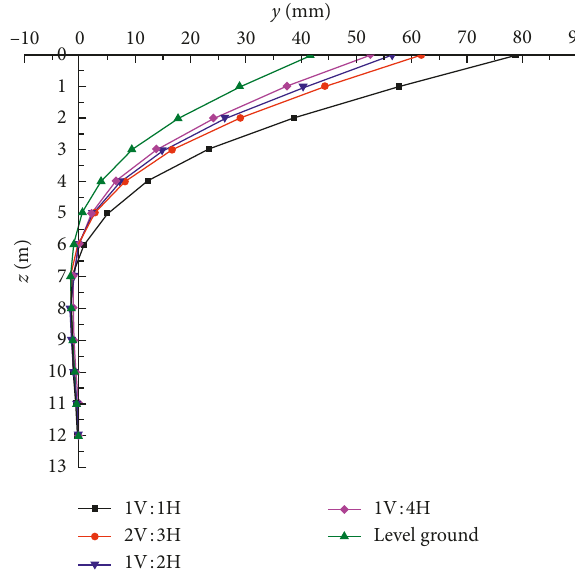
Figure 7: Pile deflection versus depth relationships of different 500kN. slope ratios for H 0 (cid:31)